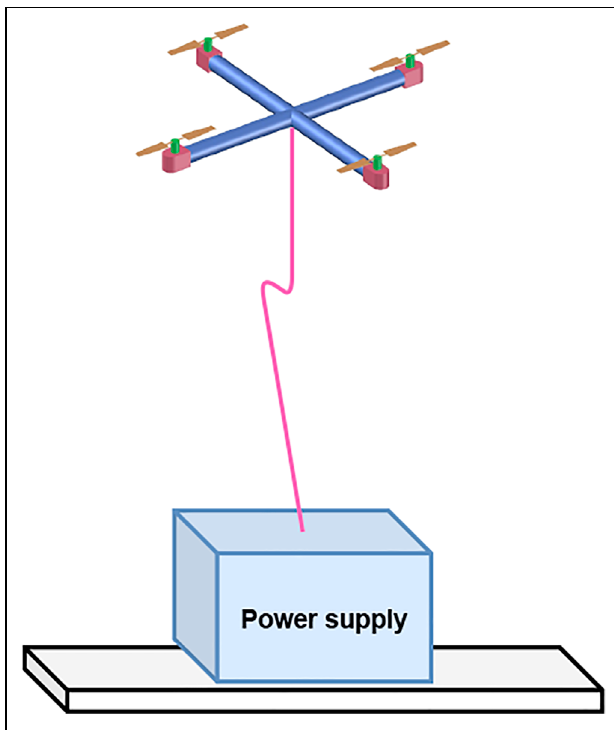
FIGURE 9 | A tethered UAV (Zikou et al.